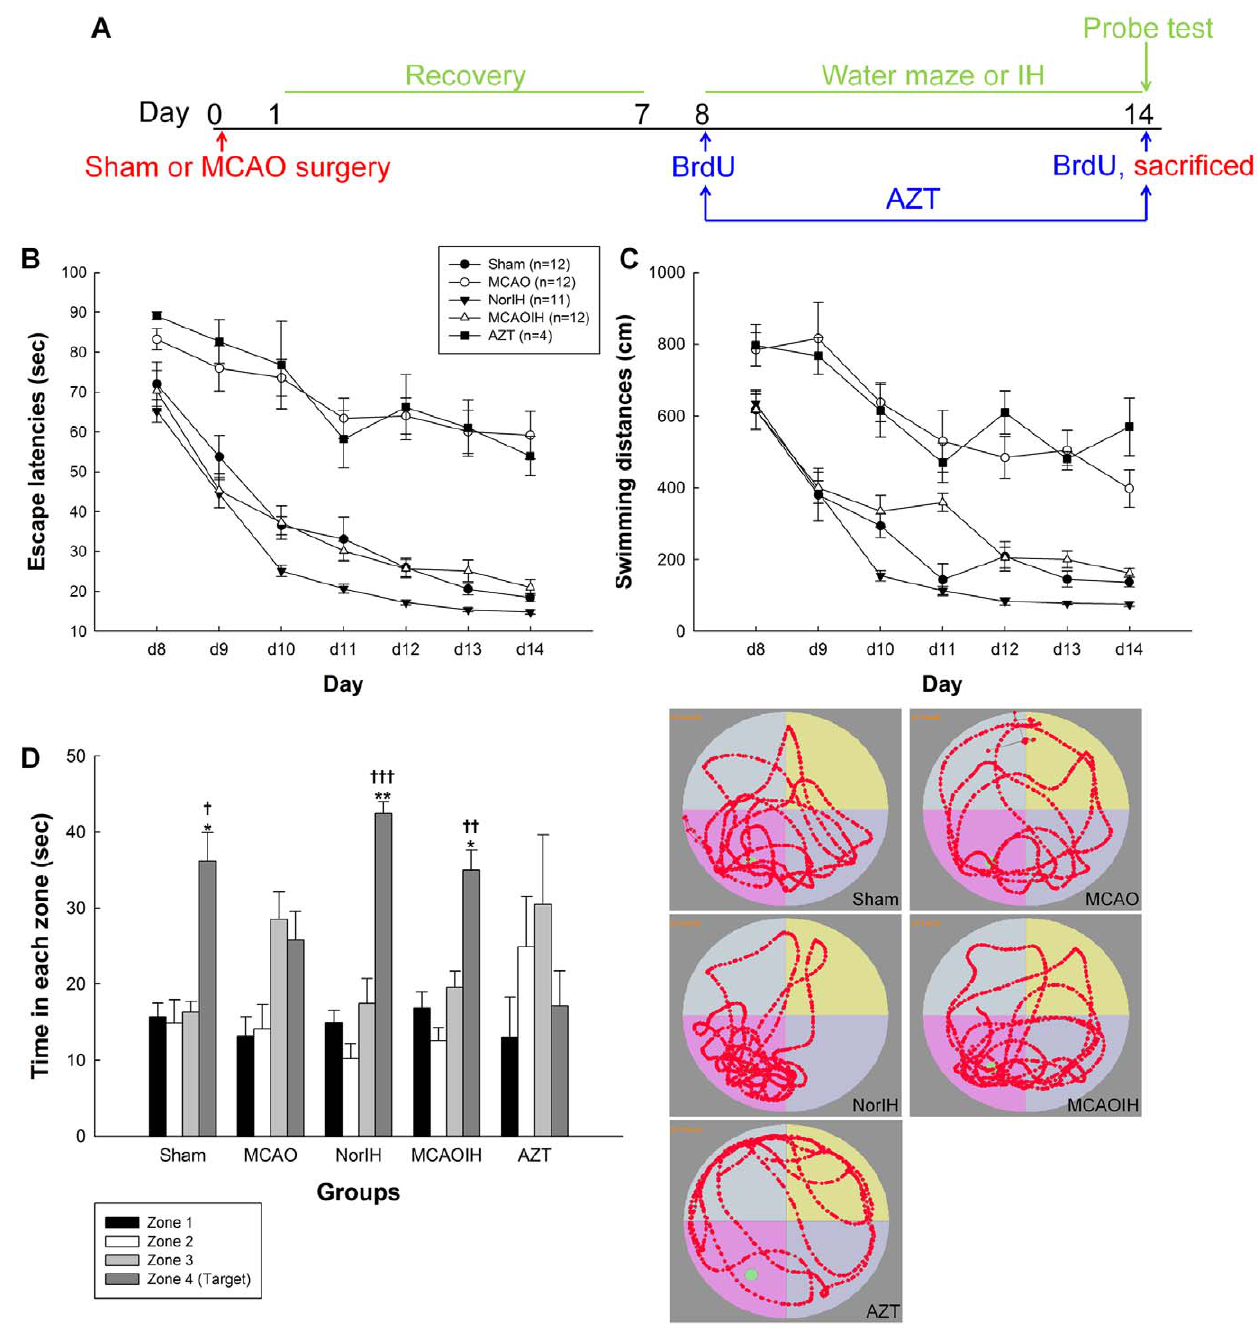
Figure 1. Reversal of spatial learning and memory impairments in ischemic rats following IH intervention. (A) Experimental design. (B) Escape latencies observed during 7 consecutive days of training on the MWM. (C) Swimming distances seen during 7 consecutive days of training on the MWM. (D, left) Time spent in the target quadrant (zone IV) during the MWM probe test. (D, right) Swim paths taken by a representative rat from each group during the MWM probe test. * p , 0.05, ** p , 0.01, compared to the MCAO group. { p , 0.05, {{ p , 0.01, {{{ p , 0.001, compared to the AZT group. doi:10.1371/journal.pone.0024001.g001 Hippocampal MAPK phosphorylation and c-Fos hippocampal MAPK phosphorylation might increase following IH intervention. To test this we sacrificed rats in the Sham, MCAO, expression are modulated similarly following IH NorIH, and MCAOIH groups after they completed the MWM intervention probe test on Day 14, then used immunoblotting to measure c-Fos expression is regulated by phosphorylated mitogen- hippocampal pMAPK expression. We observed increased activated protein kinase (pMAPK), a second messenger implicated pMAPK expression in the NorIH group ( p , 0.01) and the heavily in learning and memory [15,17]. We speculated that